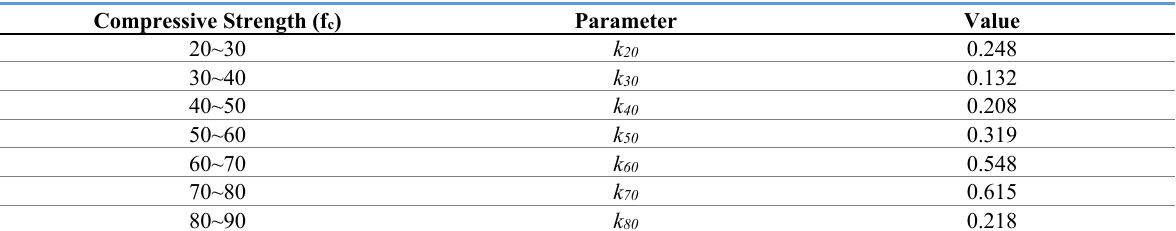
Table 4. Parameter